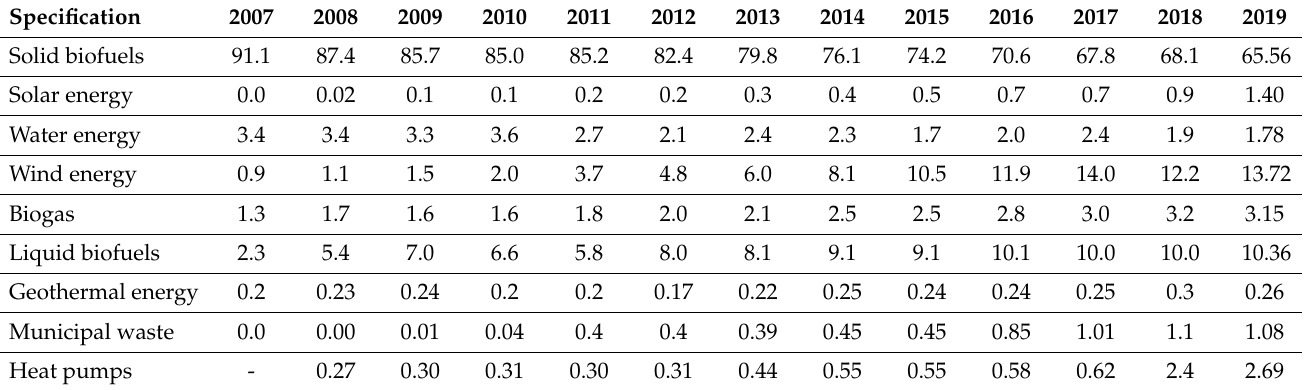
Table 1. The share of individual renewable energy sources in Poland in 2007–2019